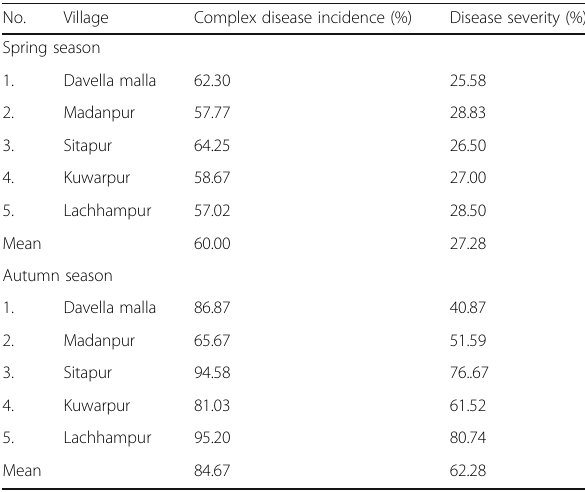
Table 1 Status of tomato diseases at farmer ’ s fields during 2013 – 2014